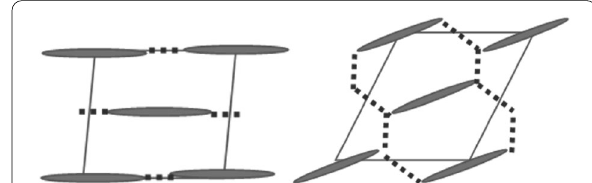
Fig. 1 Schematic diagrams of crystal lattice and hydrogen bonds of cellulose I (left) and cellulose II (right). Bars indicate glucan chains, and dotted lines indicate hydrogen